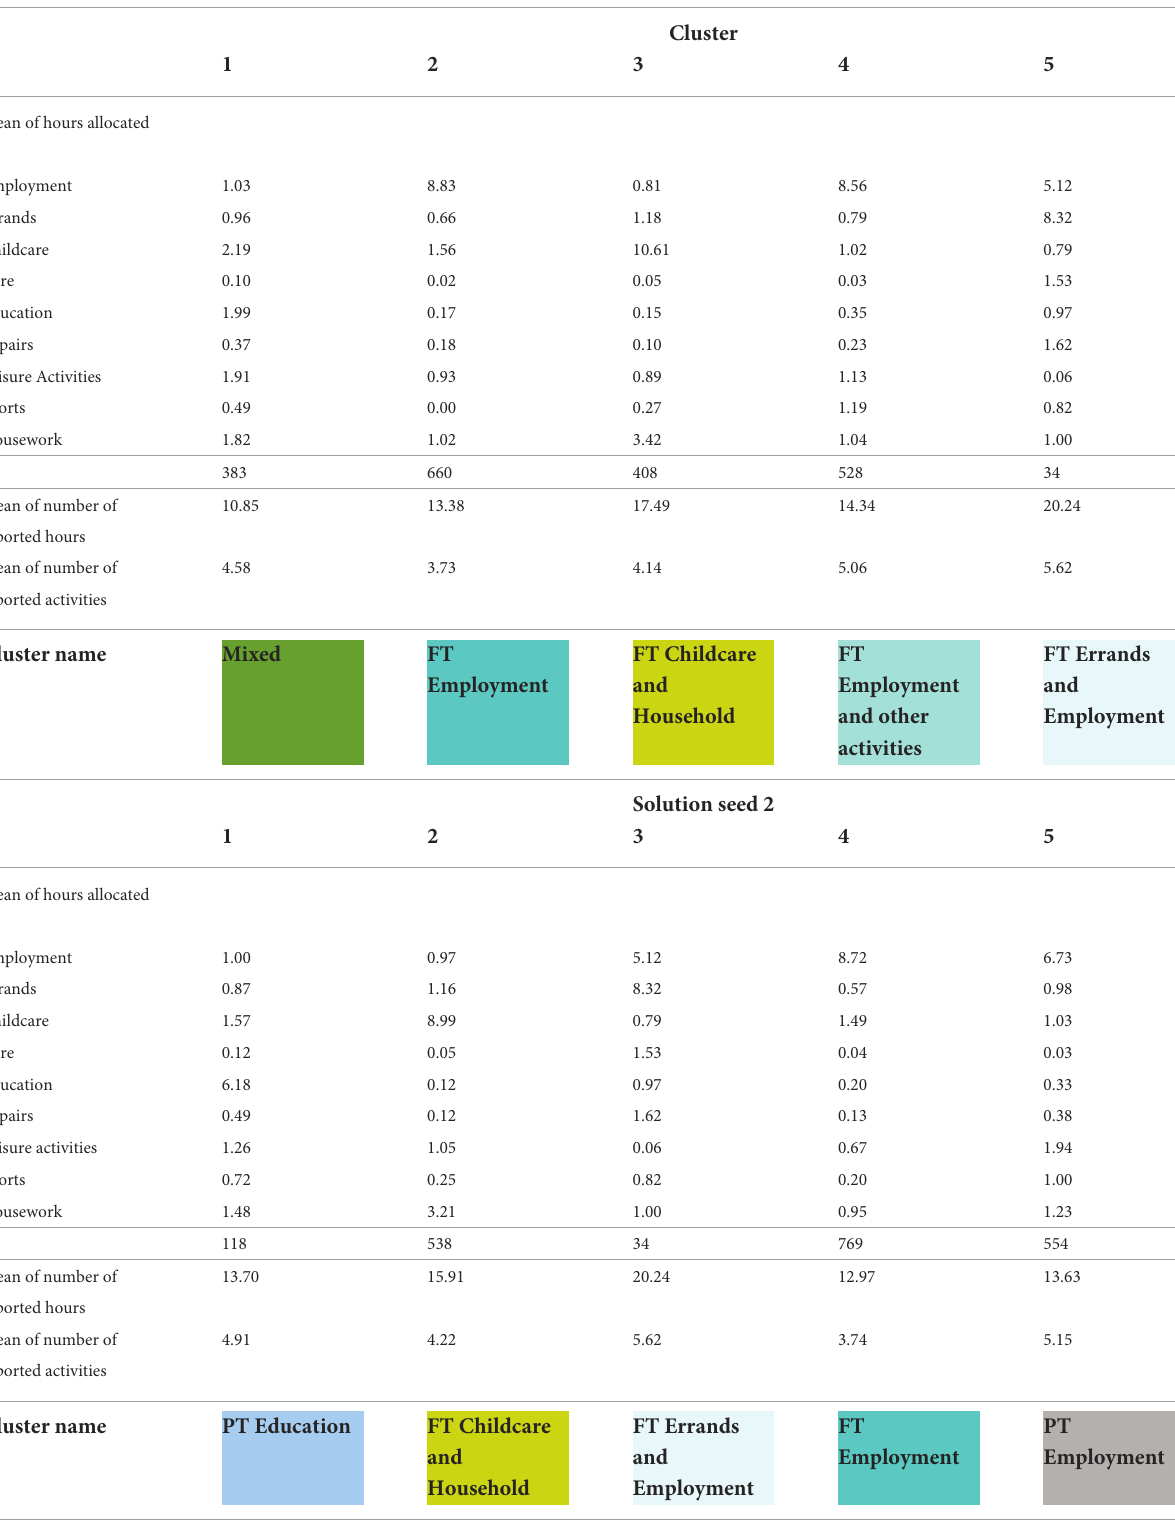
TABLE 4 Mean hours invested in activities by cluster (other